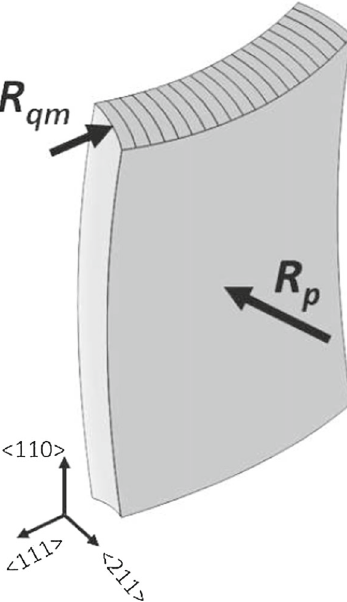
Fig. 17 Thanks to its mechanical anisotropic properties, bending of a silicon crystal along its main size to a radius R p leads to a secondary bendingalongitsthickness,manifestingwithacurvatureofradius R qm , which will be used to deflect charge particles by a bent crystal. (cid:6) 111 (cid:7) , (cid:6) 110 (cid:7) and (cid:6) 211 (cid:7) represent the directions of crystallographic axes